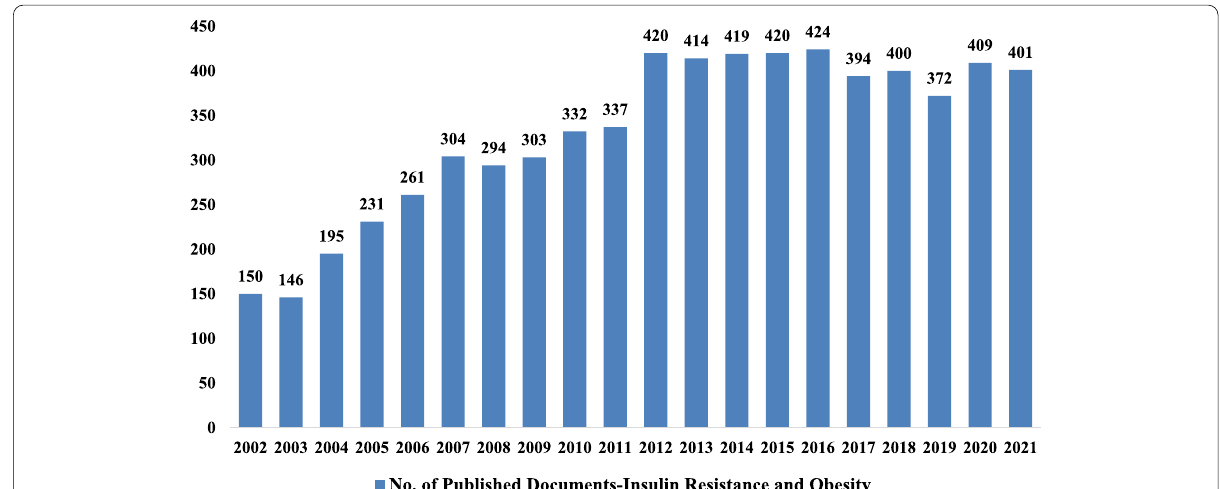
Fig. 2 Distribution of publications on insulin resistance and obesity according to the year